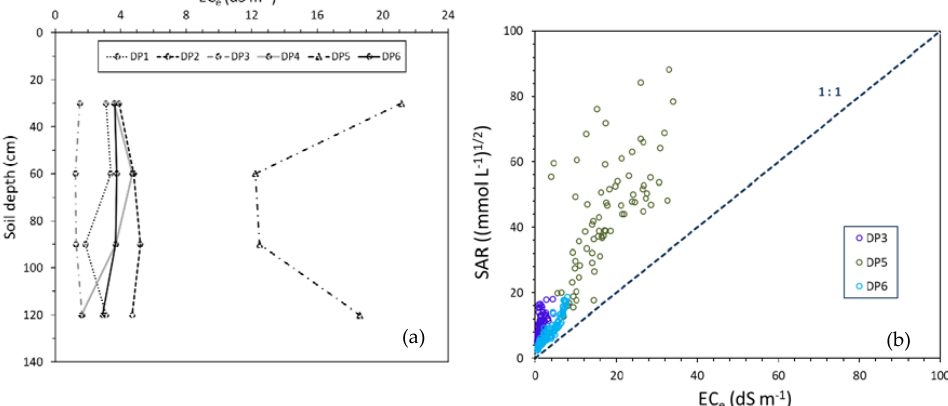
Figure 5. Whole-soil profile representations of ( a ) mean EC e (electrical conductivity of the saturation extract) distribution of observed values at six experimental date palm sites and ( b ) soil SAR (sodium adsorption ration) versus EC e at the DP3, DP5, and DP6 sites. The complete data from the 24 soil core sampling locations were used to plot SAR vs. EC e . The salinity surveys were conducted in April through June 2019.